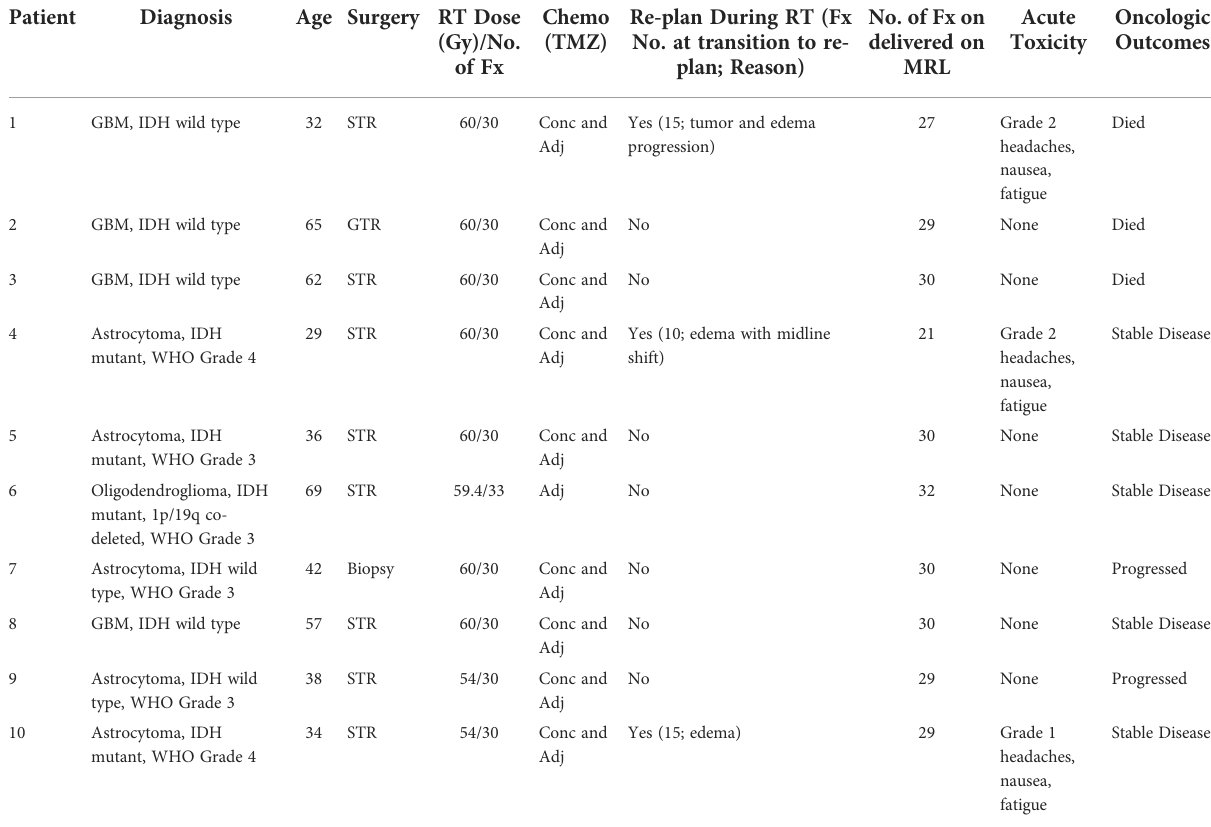
TABLE 2 Detailed patient treatment characteristics and clinical outcomes.